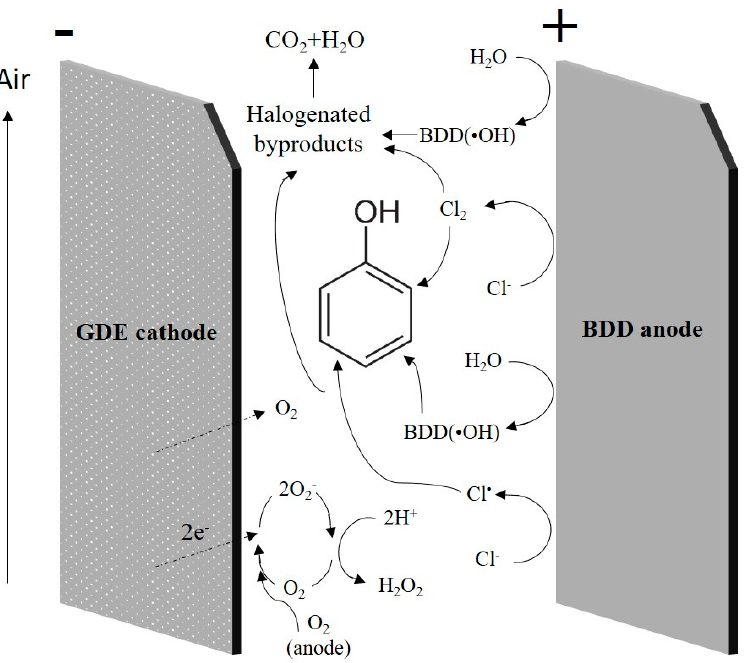
Figure 6. Schematic representation of the EO operation principle (example of phenol oxidation as model organic compound) (Reprinted with permission from Ref. [103], 2022, Elsevier).